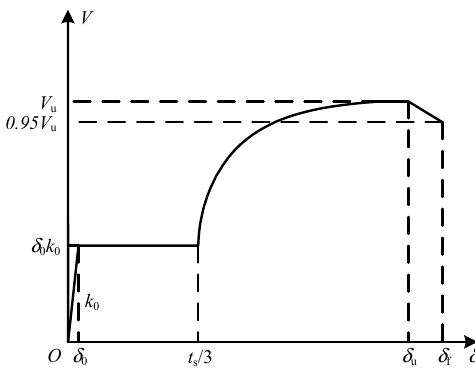
Figure 6. Shear-slip model of the URSP connector.